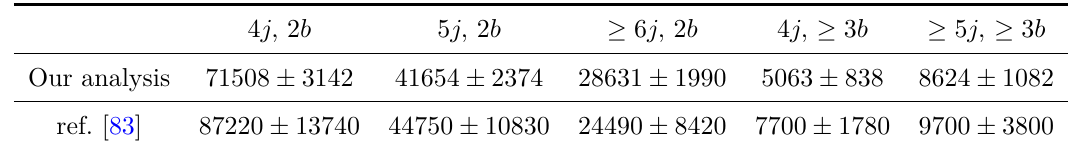
Table 4 . ttjs : expected number of events for tt production at with our analysis code and by the ATLAS collaboration in ref. [83]. For our analysis we only show the statistical errors from the limited MC samples we used, whereas the errors ref. [83] are dominated by systematic